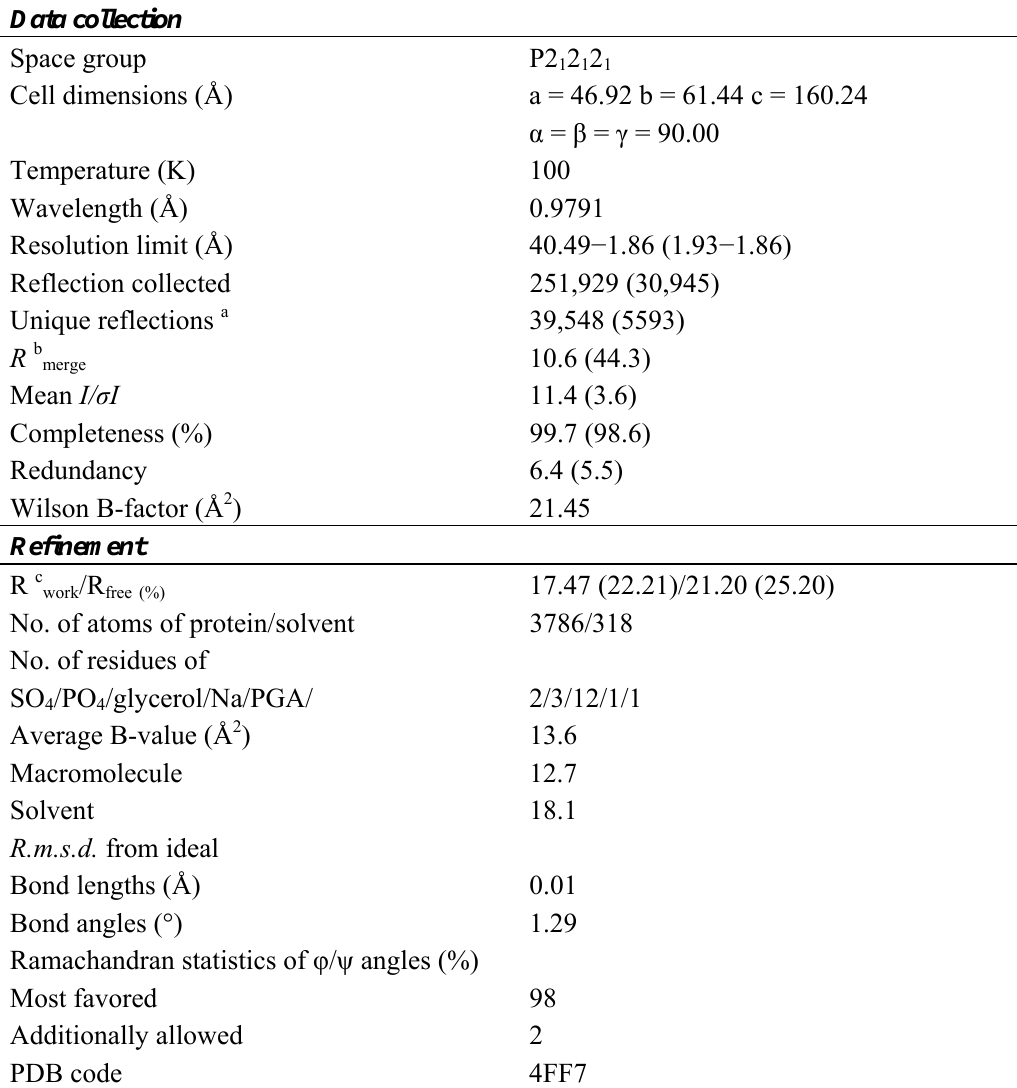
Table 1. Data collection and structure refinement